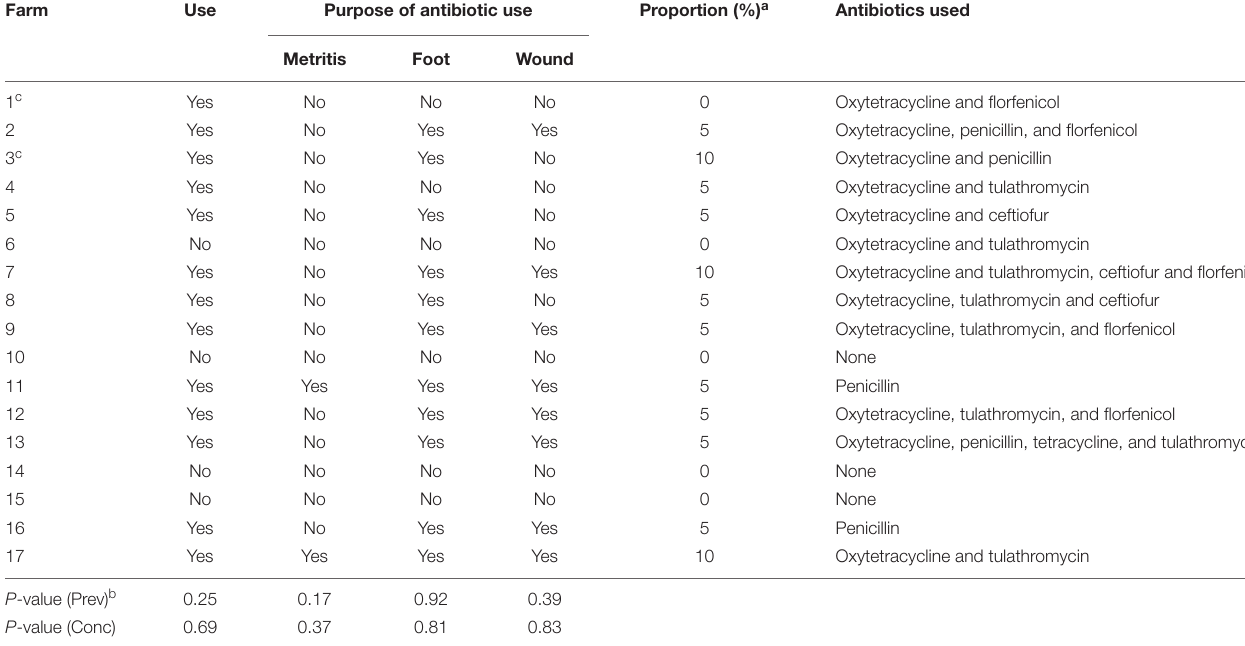
TABLE 4 | Association between farm antibiotic usage and CRB prevalence and concentrations.